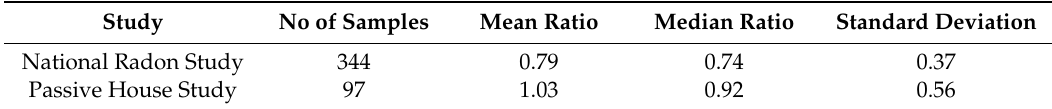
Table 2. Radon distribution analysis comparing the data in this study against the NRS 2015.